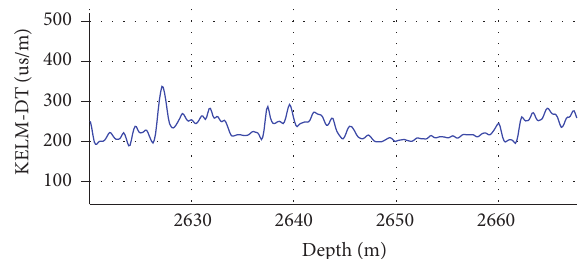
Figure 4: Estimated DT log using KELM model (colored in blue) for